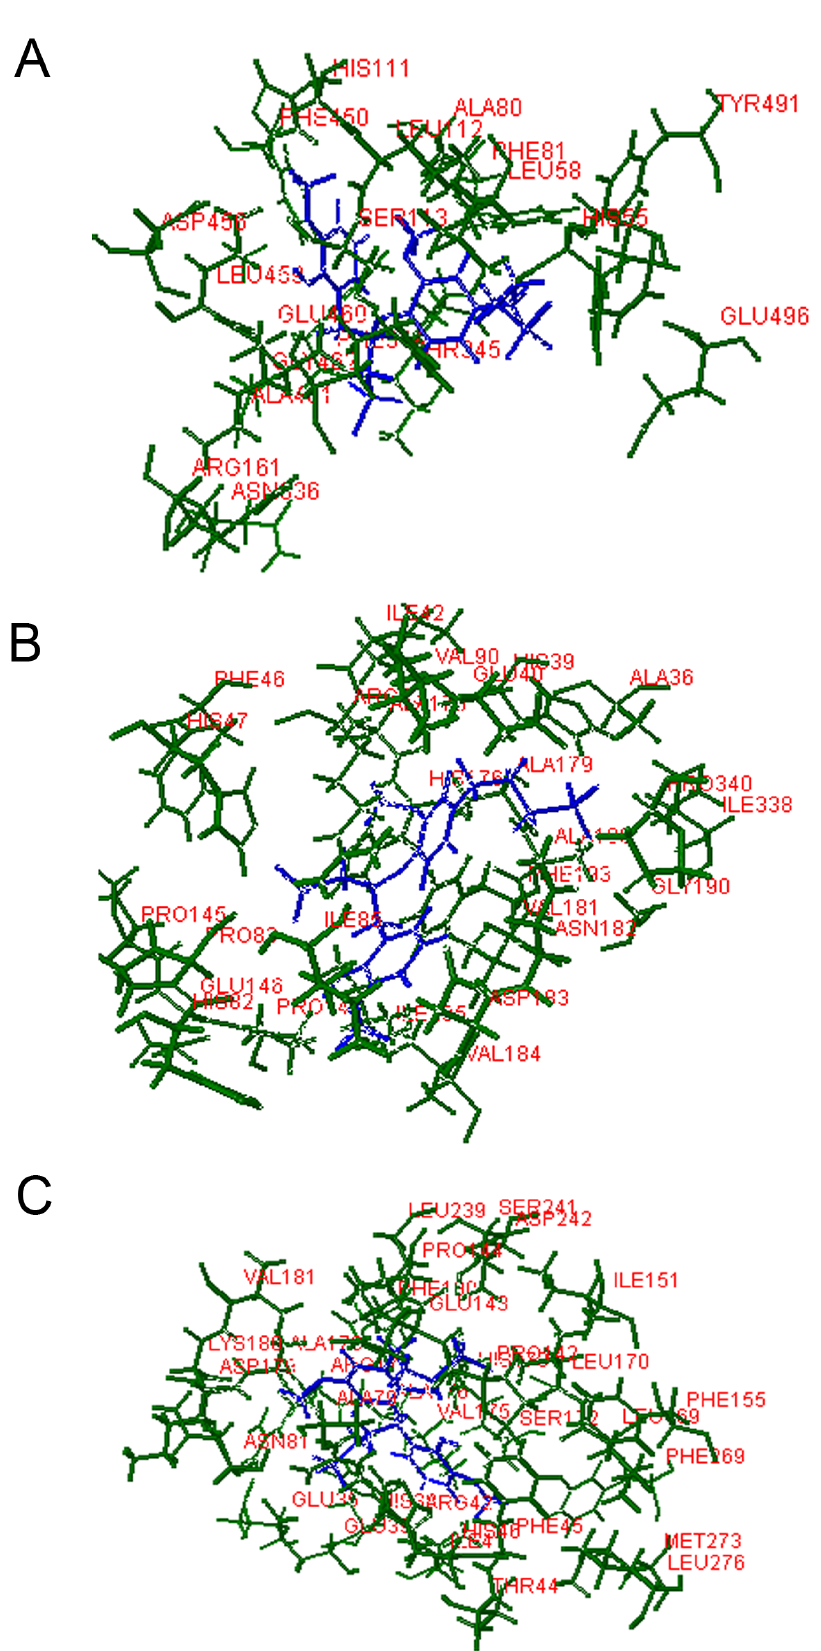
Figure 2. 3D stick model representations of binding modes and binding interactions between ligninolytic enzymes and lignin (colored by element: green , ligninolytic enzyme; blue , lignin). (A) Lac-lignin system. (B) LiP-lignin system. (C) MnP-lignin system. doi:10.1371/journal.pone.0025647.g002 PLoS ONE |